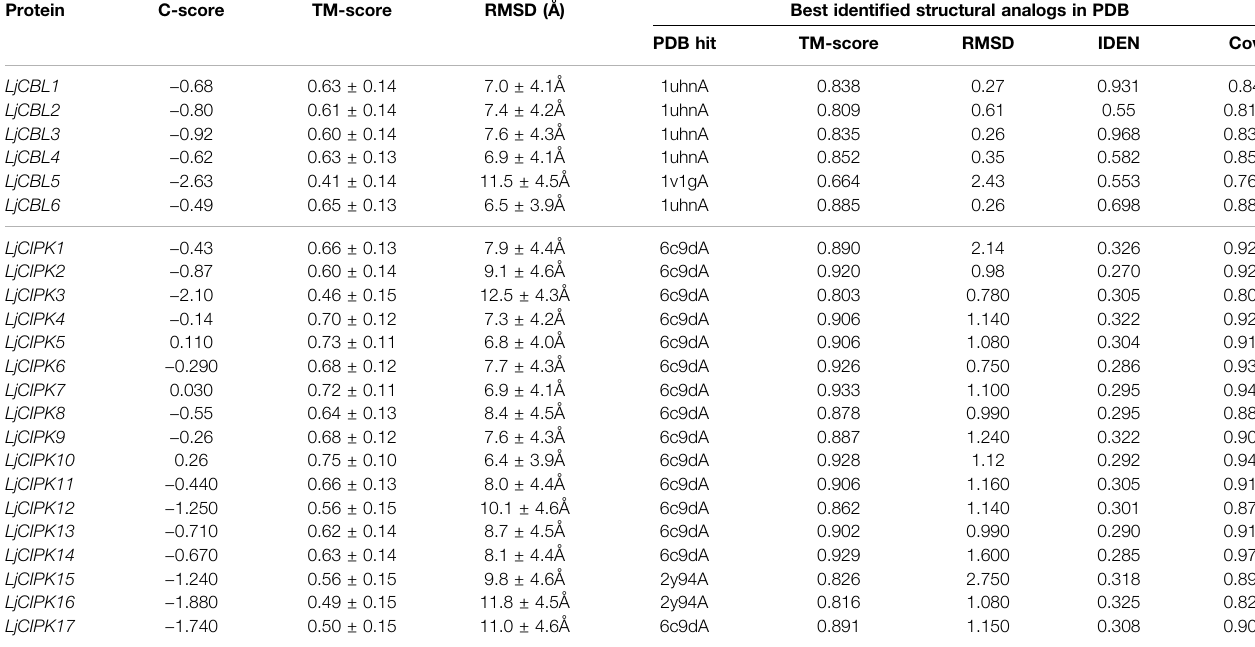
TABLE 3 | Structural dependent modeling parameters for the CBL-CIPK proteins. Protein